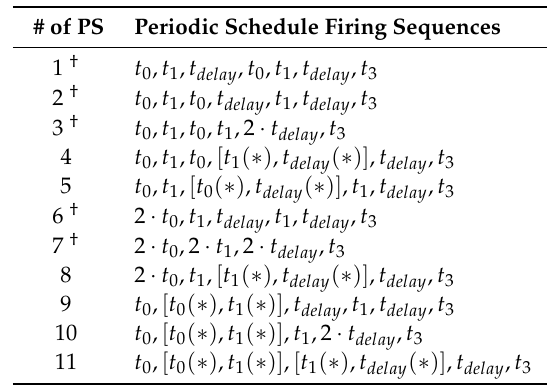
Table 2. Possible firing sequences (PS, Periodic Schedule) with an initial marking vector [ p 0 p 1 p 2 p ] = [ 0 0 2 0 ] under a maximal step firing strategy.